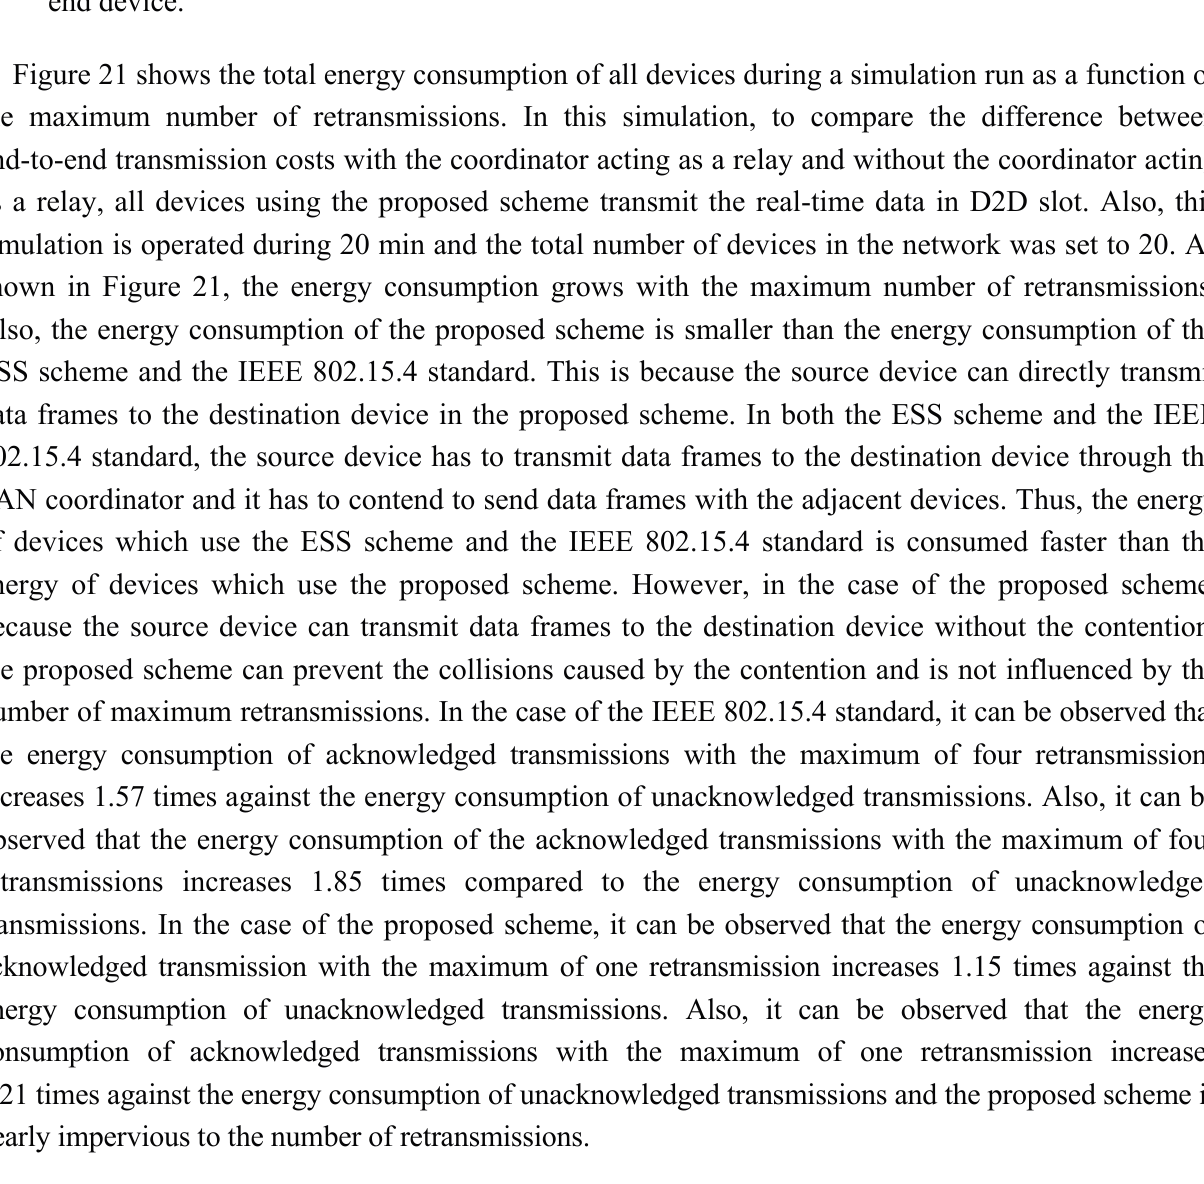
Figure 20. The energy consumption of device versus the distance between coordinator and end